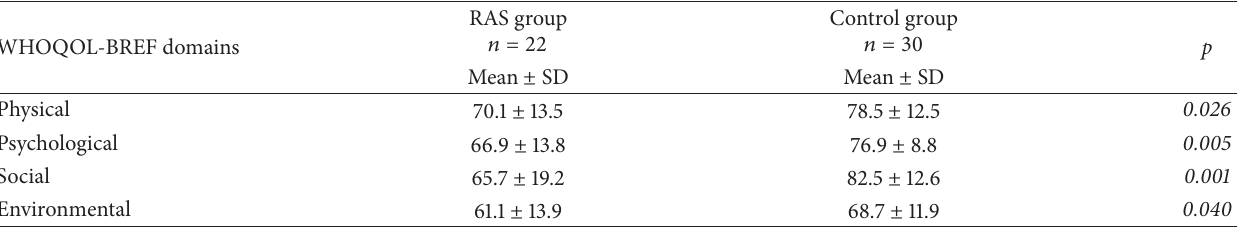
Table 4: Scores of physical, psychological, social, and environmental domains of the World Health Organization Quality of Life-bref (WHOQOL-BREF) inventory in the RAS and control